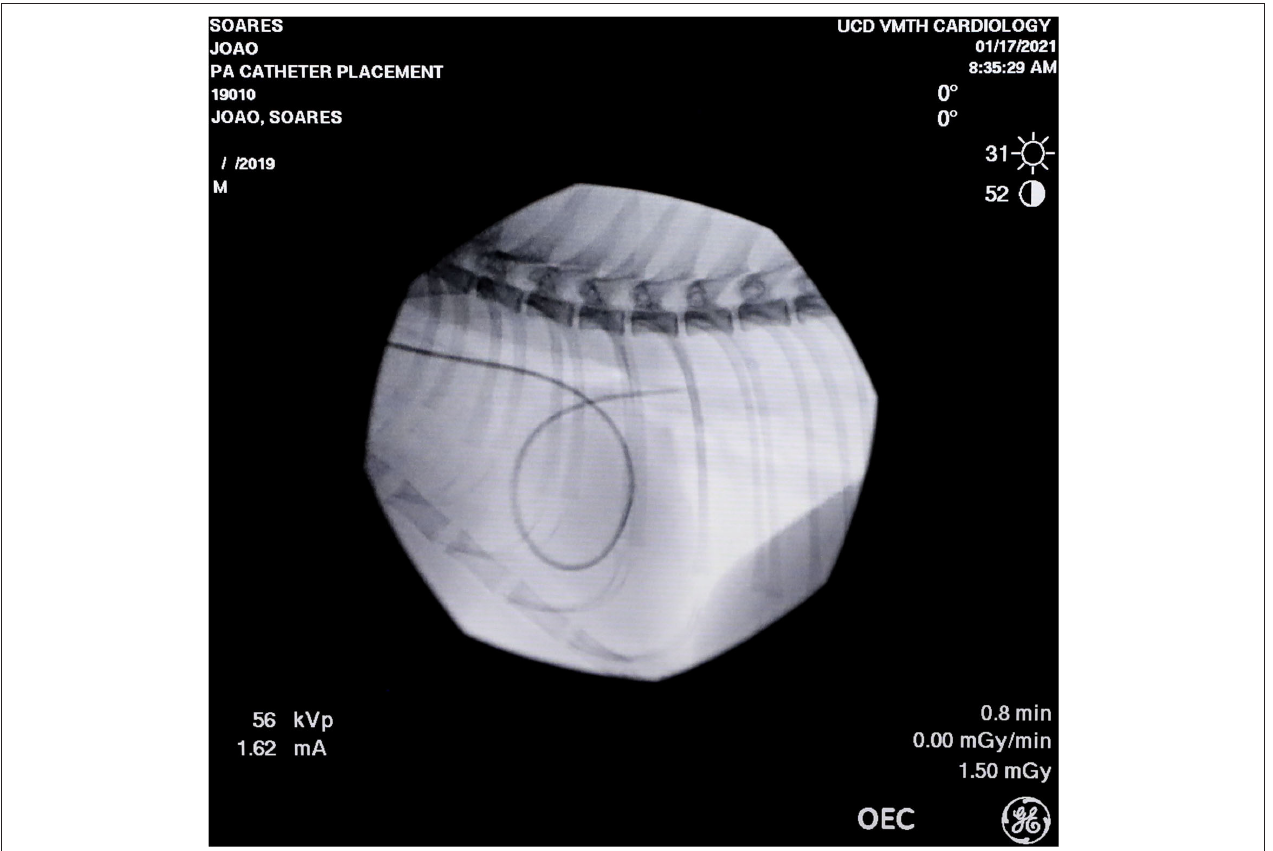
FIGURE 1 | Fluoroscopic image of the thermodilution catheter positioned at the pulmonary artery of one of the studied